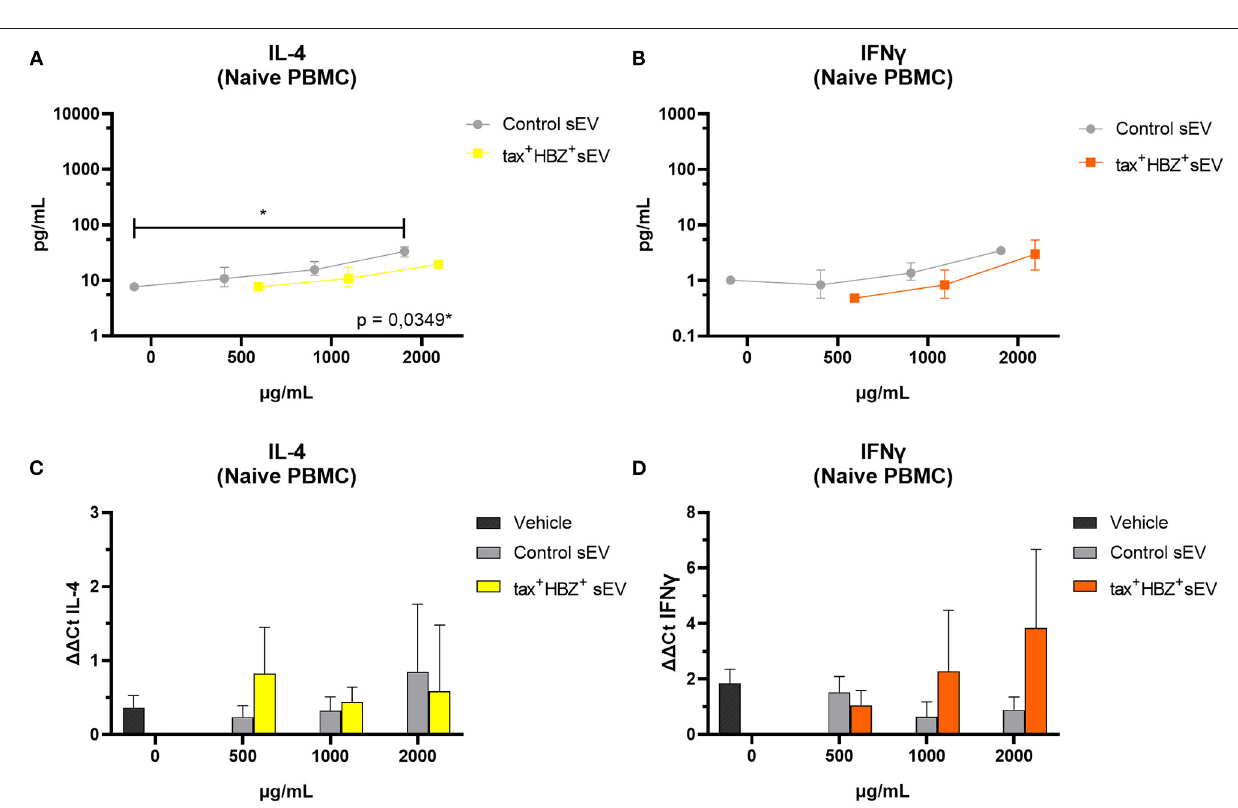
FIGURE 4 | Inflammatory cytokines expression and secretion in naive PBMCs treated with tax + HBZ + sEV. The secretion of interleukin (IL)-4 and interferon (IFN)- γ (A,B) was analyzed in total protein extract of naive PBMCs ( n = 3) treated with 500, 1,000, and 2,000 µ g/ml of tax + HBZ + sEV. Graphs A and B show the average IL-4 and IFN- γ concentration ± standard deviation (SD) in pg/ml in response to each sEV treatment. The same conditions were analyzed by quantitative PCR (qPCR). Graphs (C,D) show the average IL-4 and IFN- γ mRNA relative expression ( 11 Ct) ± SD in response to each sEV treatment. Statistical analysis was performed by Kruskal–Wallis with Dunn’s post-hoc test: * p <